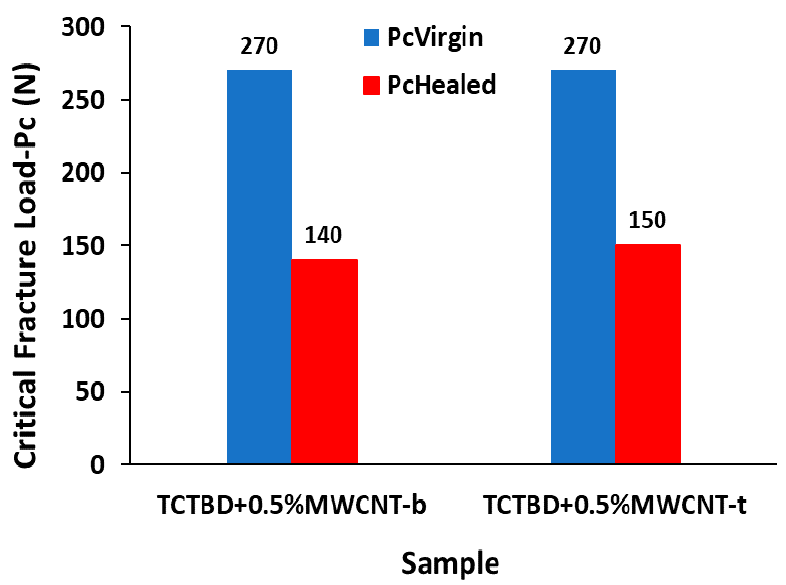
Figure 19. Histogram showing the values of both the critical fracture load Pc of the virgin samples (PcVirgin) and the healed samples (PcHealed) for the two nanocomposites: TCTBD+0.5%MWCNT-b and TCTBD+0.5%MWCNT-t subjected to the TDCB fracture test.